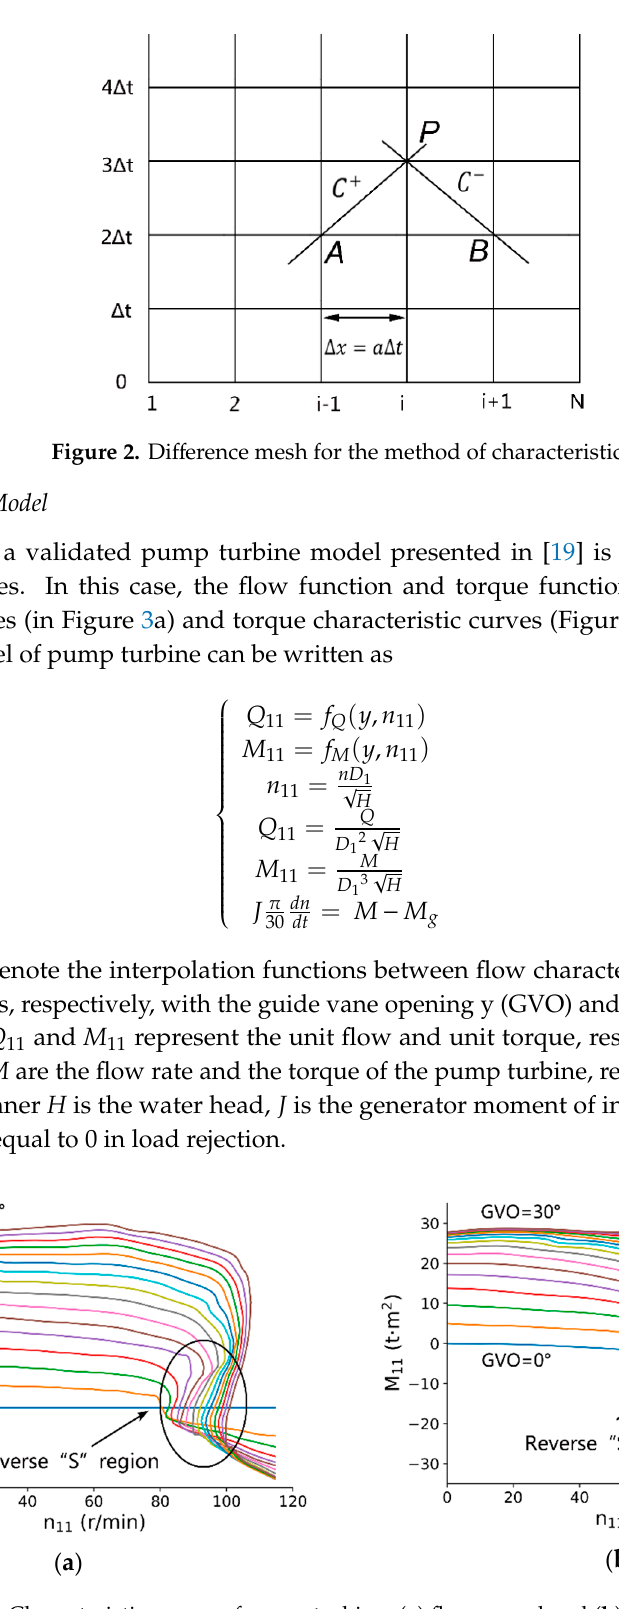
Figure 3. Characteristic curves of pump turbine: ( a ) flow–speed and ( b ) torque–speed.